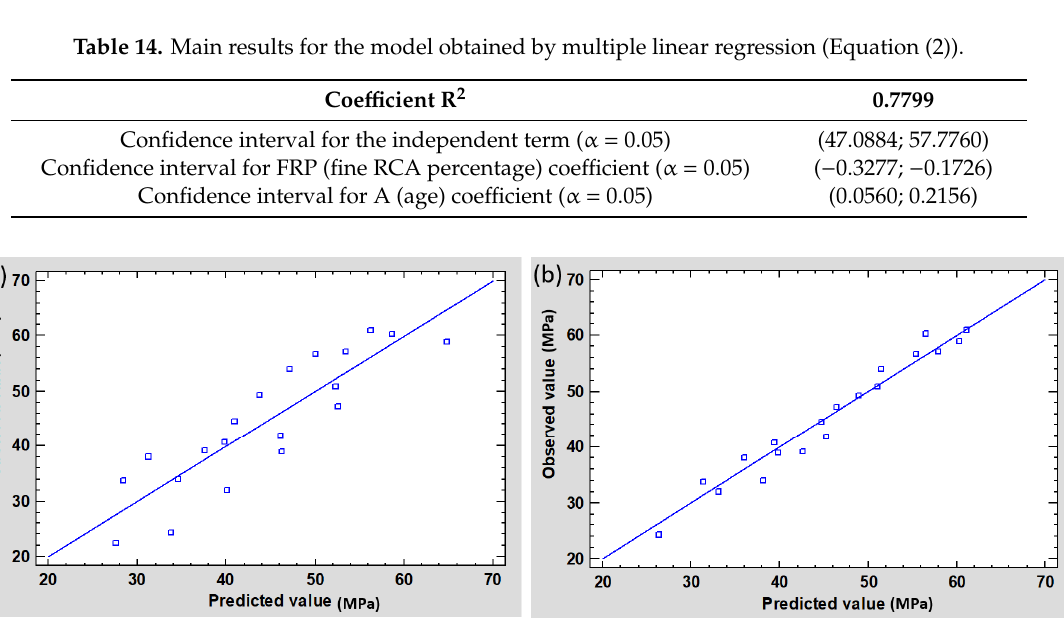
Figure 8. Relationship between observed values and estimated values of compressive strength: ( a ) linear model; ( b ) multiple regression proposed model.